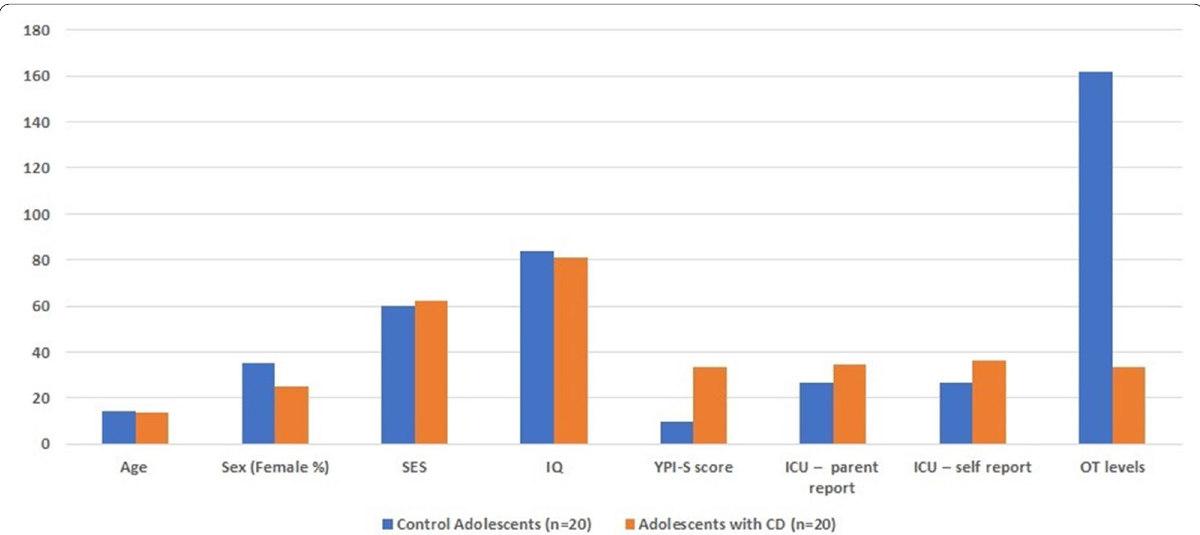
Fig. 1 Comparison between adolescents with conduct disorder (CD) and control adolescents regarding demographic, clinical data, and serum oxytocin levels